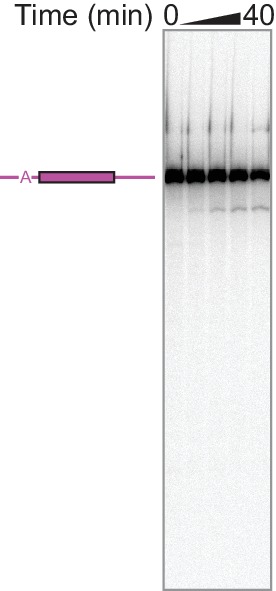
Bulk assay detects no splicing of 3e5 pre-mRNA.Time points are 0, 10, 20, 30, and 40 min after nuclear extract addition.